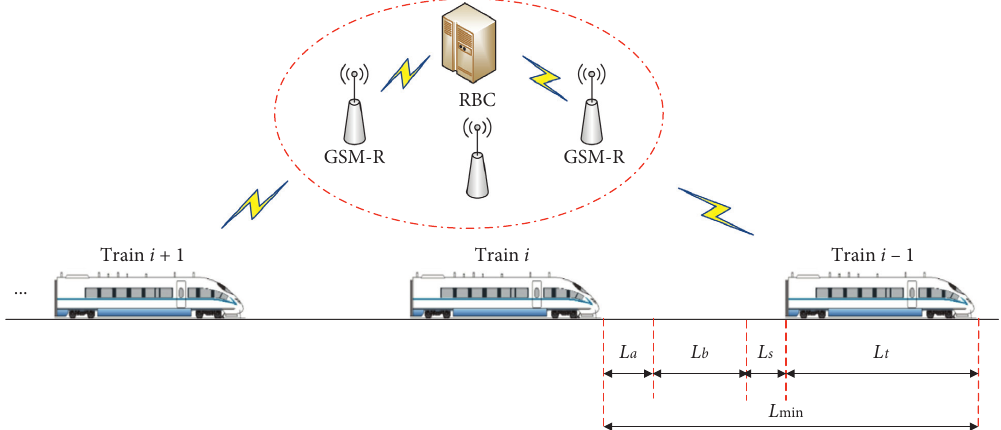
Figure 1: Cooperative operation model of MHSTs under moving block condition.